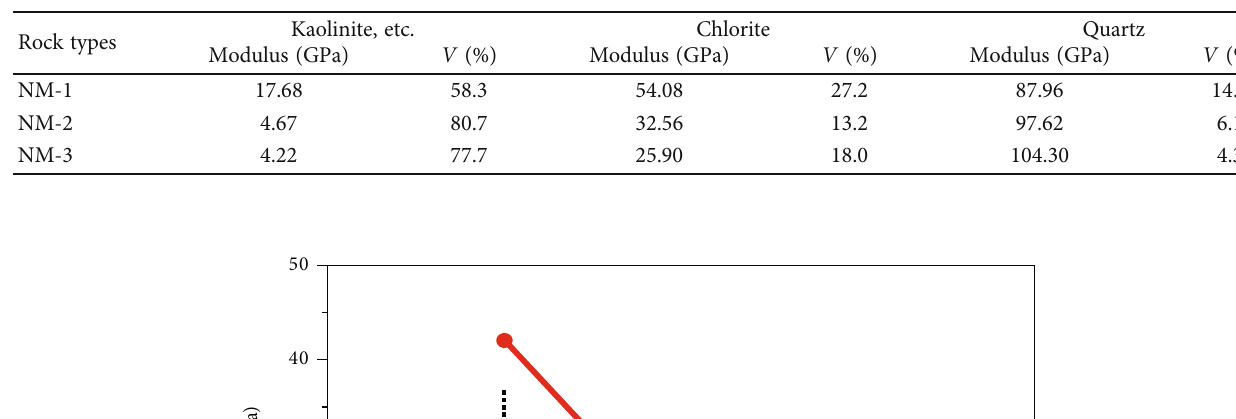
Table 3: Statistical results of indentation modulus for three mudstone specimens.